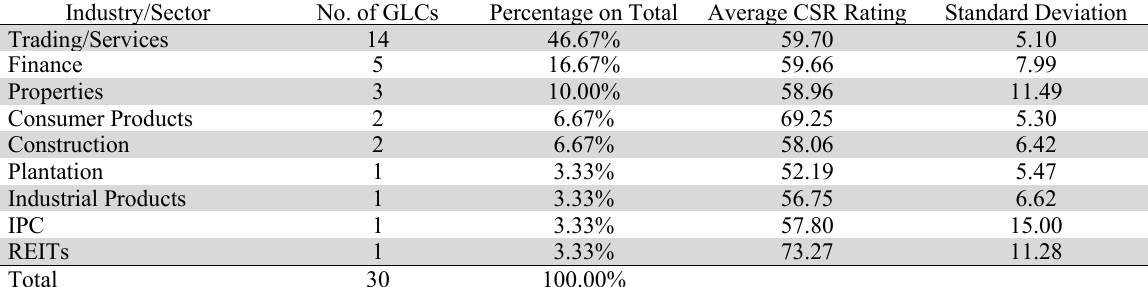
Average CSR Ratings based on